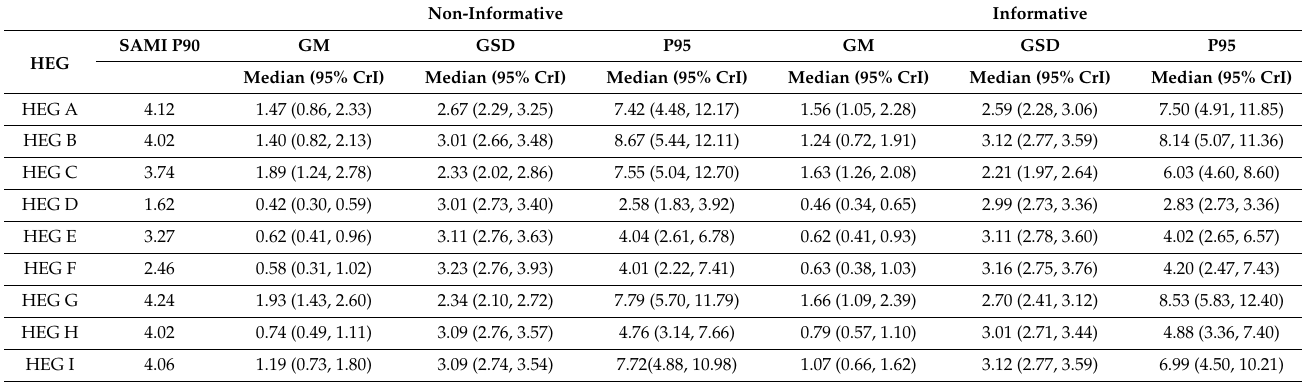
Table 3. The median (95% credible interval (CrI)) of the posterior GM, GSD, and the P95 percentiles and the SAMI